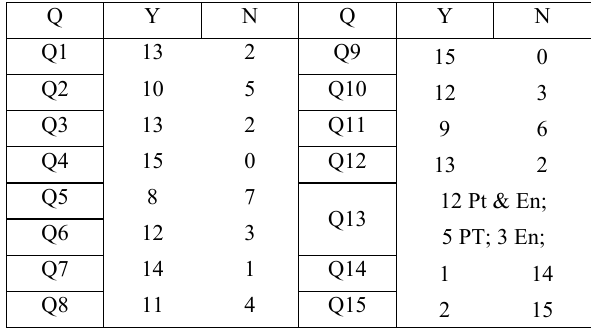
Table 3. TOP15 Lisbon caches.